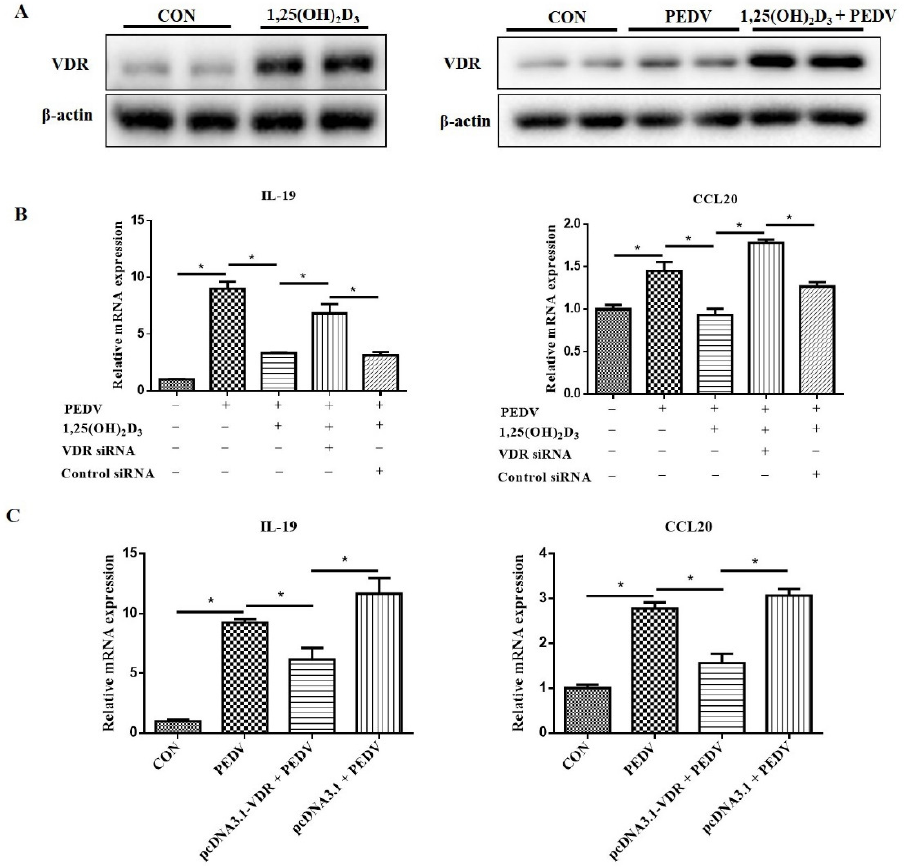
Figure 9. Effects of VDR on inflammatory cytokine expression in PEDV-infected IPEC-J2 cells. Sub- confluent cells were incubated with 1,25(OH) 2 D 3 (20 nM) for 24 h, and then the cells were collected for Western blotting analysis or continued to be infected with PEDV (1 MOI). After 1 h of absorption, the cells were washed with PBS and then cultured with or without 1,25(OH) 2 D 3 (20 nM) for further 24 h. Then, the cells were collected for Western blotting analysis ( A ). After the IPEC-J2 cells were transfected with VDR siRNA for 24 h, 1,25(OH) 2 D 3 (20 nM) was supplemented for another 24 h, and then cells were infected with PEDV (1 MOI) and cultured for a further 24 h. Finally, the cells were harvested for RT-qPCR tests ( B ). The pcDNA3.1-VDR was transfected into IPEC-J2 cells by Lipofec- tamine 3000 reagent and cultured for 24 h, after which the cells were infected by PEDV and cultured for a further 24 h. Then, the cells were collected for RT-qPCR analysis ( C ). * p < 0.05.